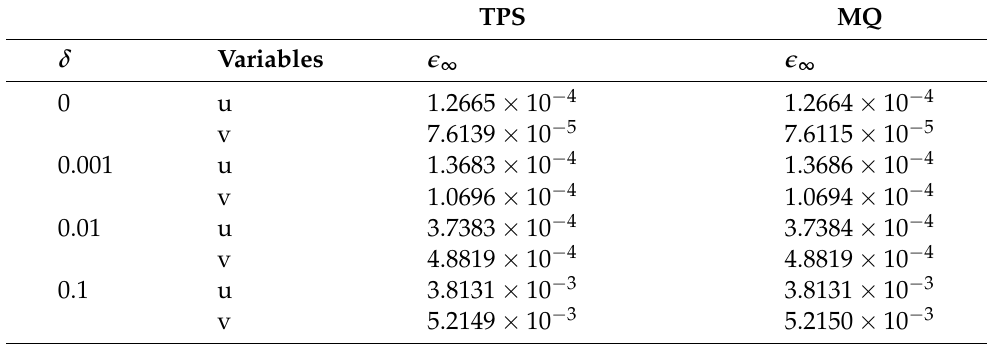
Table 9. The effect of noise on error estimates of Example 3 for N = 1496, τ = 0.5 ( dx ) 2 , and n c =